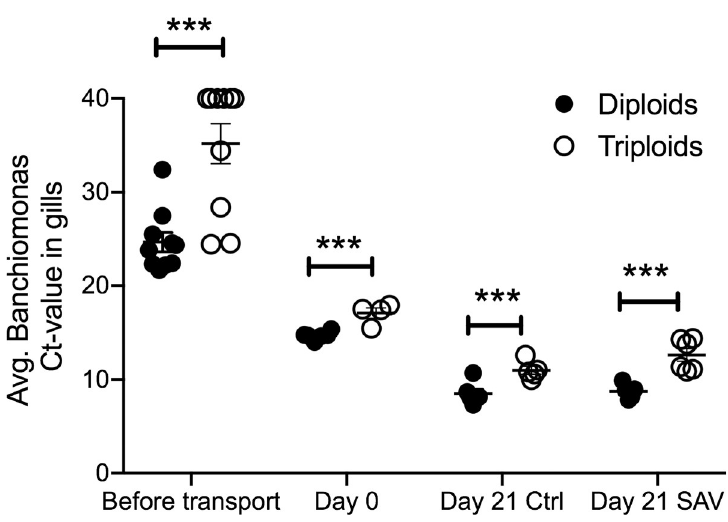
Fig 6. Mean Candidatus Branchiomonas Ct values in gill samples of diploid and triploid Atlantic salmon as determined by RT-qPCR. ��� indicates P- values < 0.001 by Paired Student’s T-test.